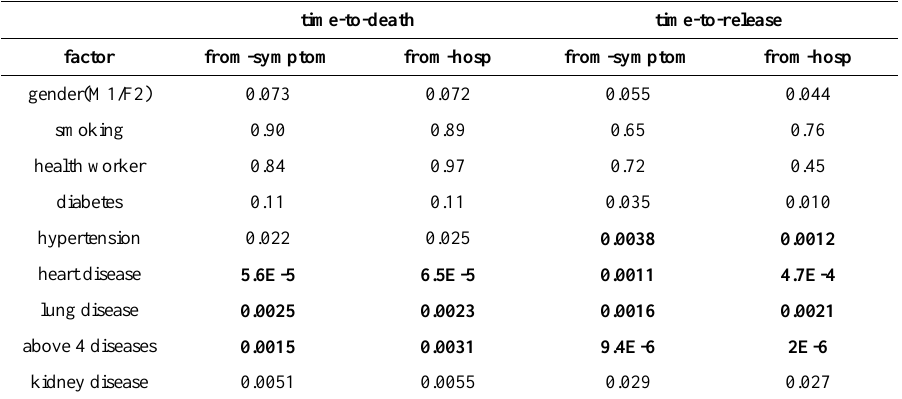
Table 2. The p-values of single-variable competing-risk survival analysis by Fine-Gray model (discrete/categorical factors only) Test p-values of discrete risk factor’s association with COVID-19 by Fine-Gray model